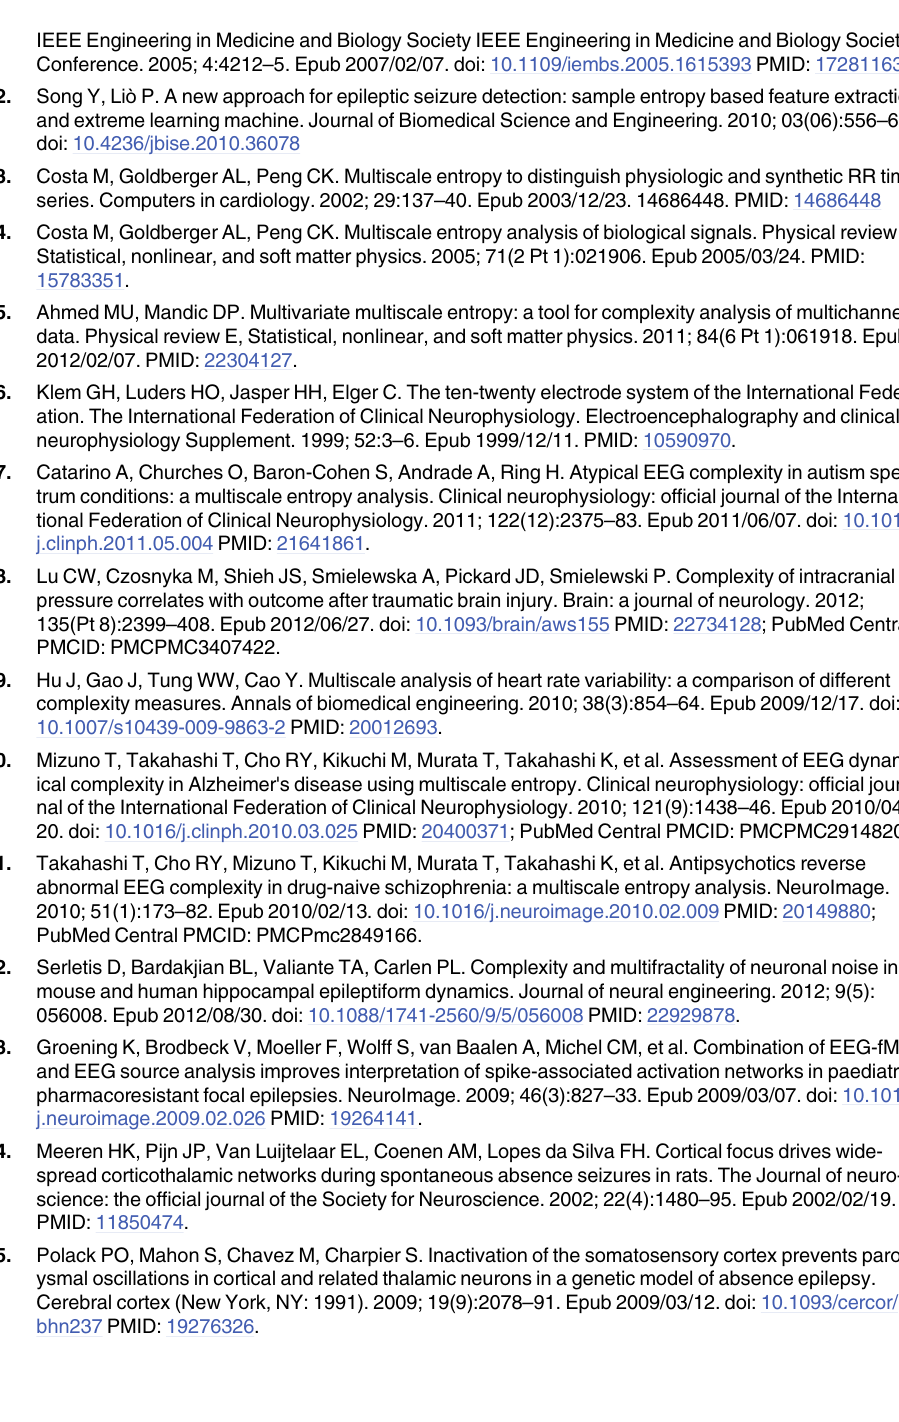
PLOS ONE | DOI:10.1371/journal.pone.0134083 August 5,